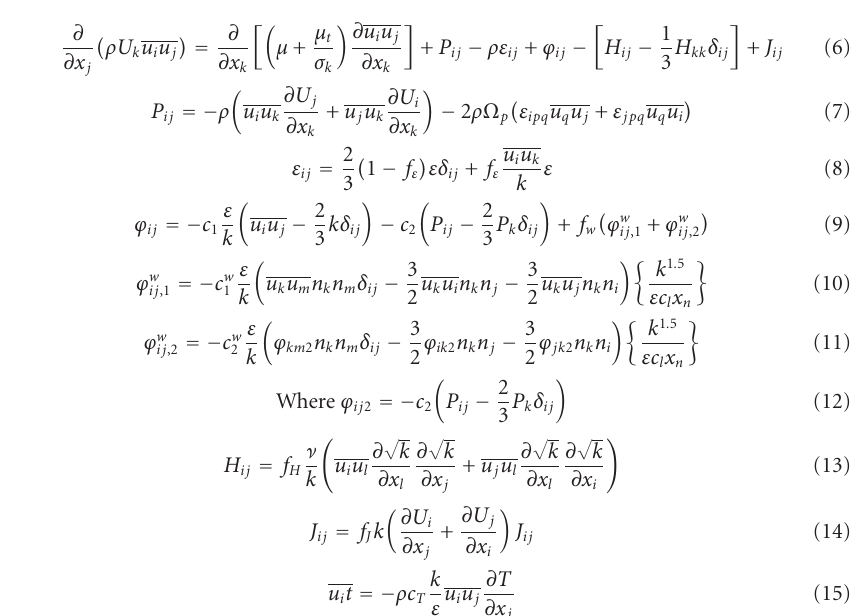
Table 1: Equations for the basic low-Re DSM